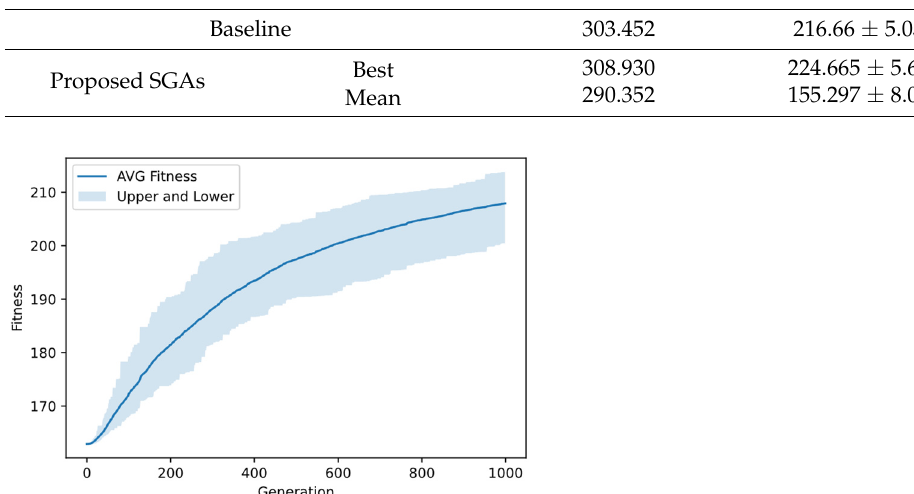
Figure 9. Fitness of the proposed SGAs for the lunar lander problem according to generation.